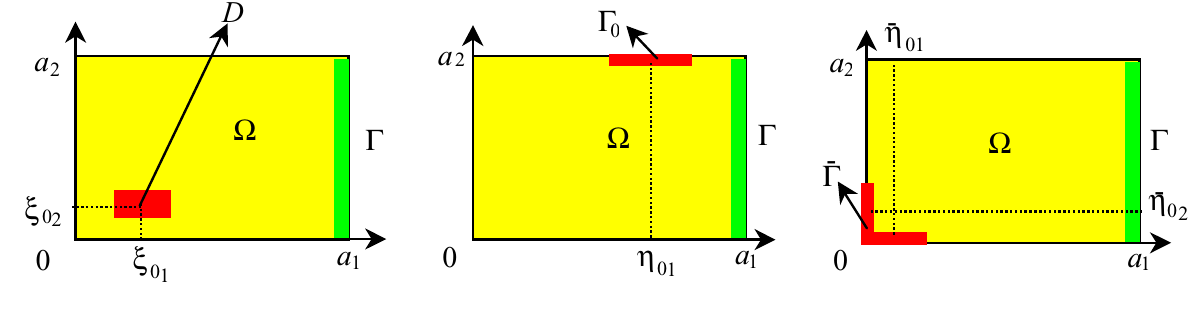
Figure 4. Domain Ω , region Γ and locations D , Γ